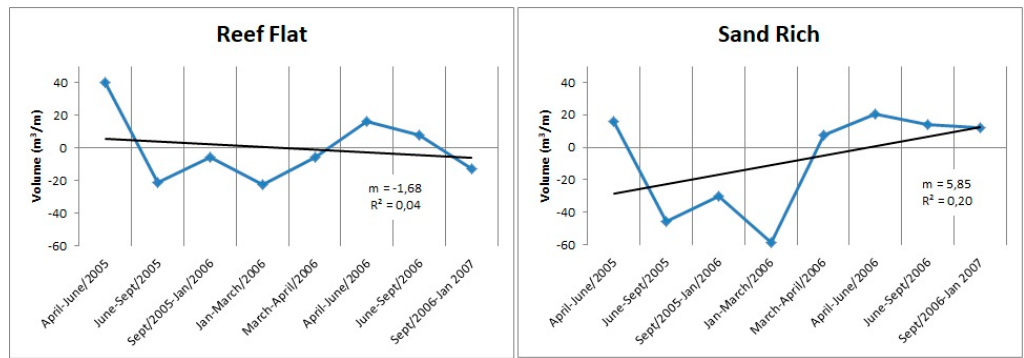
Figure 5. Evolution of sand volume of two types of beaches (reef flat, RF, and sand-rich, SR) during the April 2005–January 2007 period. Units of the linear regression slope (m) are in m 3 /m per month.